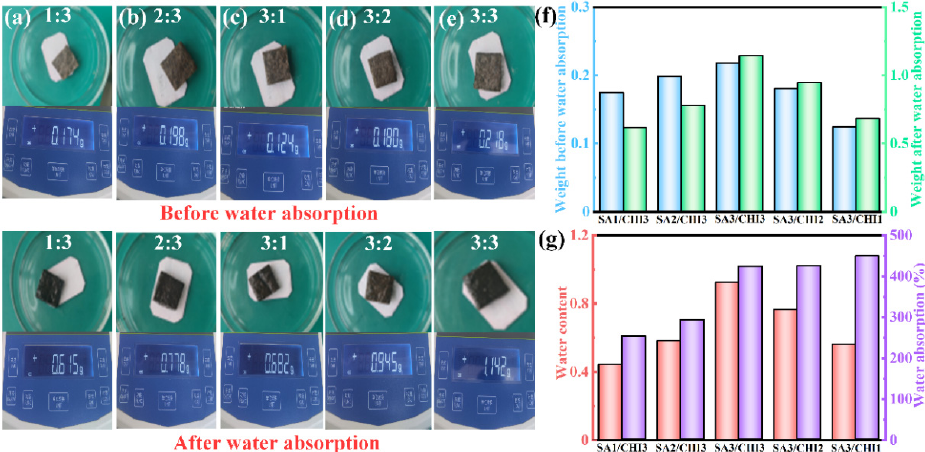
Figure 7. ( a – e ) Photographs of various SA/CHI sponges before and after water absorption. ( f , g ) Weight and water absorption ratio R w for various samples,